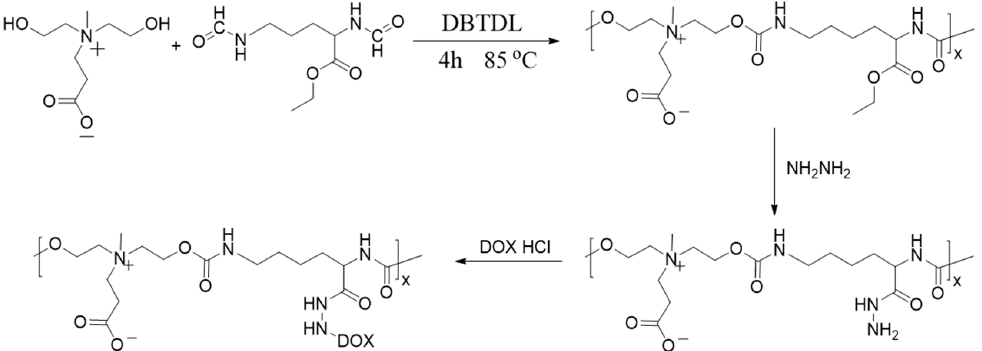
Figure 1. Detailed synthetic route of the PU-hyd-DOX.